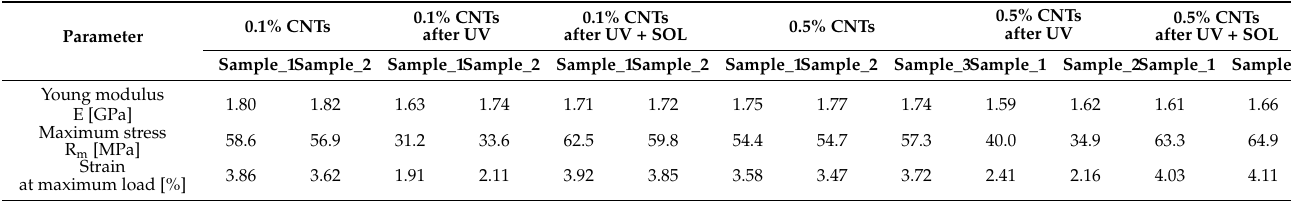
Table 3. Characteristic parameters obtained in tensile test for samples 4032D with admixture of CNTs. Parameter